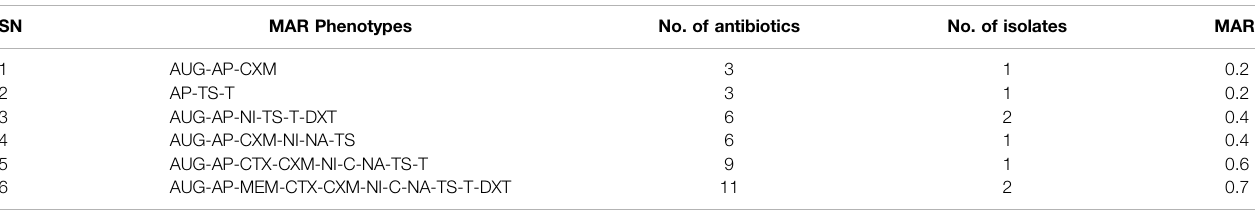
TABLE 3 | The MARPs and MARI of the pathogenic strains of E. coli retrieved from agricultural soil samples. SN MAR